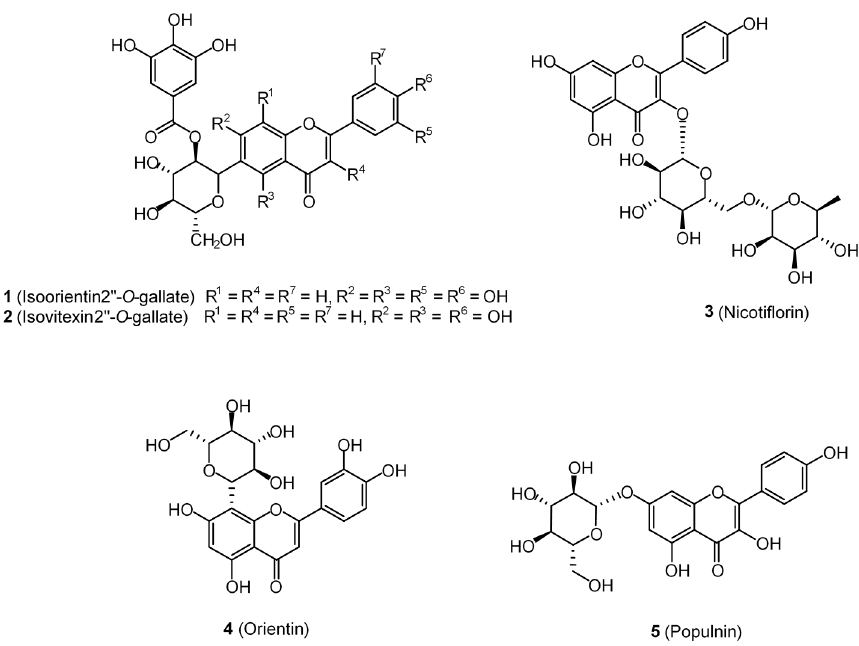
Figure 1. Structures of Pelargonium flavonoids ( 1–5 ). Table 3. Detailed molecular interactions obtained following the rigid ligand docking of Pelargonium compounds ( 1 ) to ( 5 ), with Mt